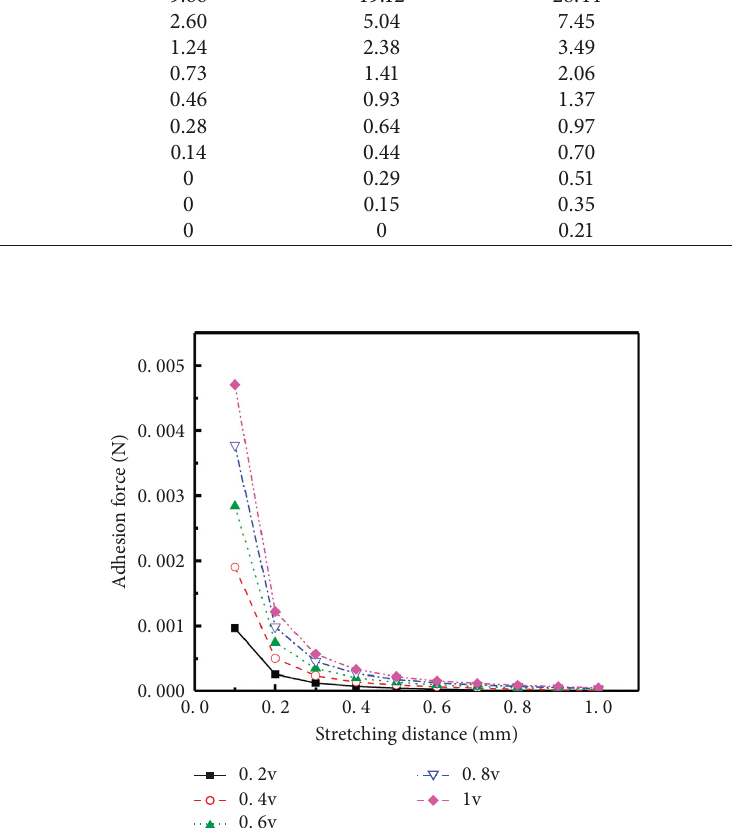
Figure 7: Variation curve of adhesion force of different liquid bridge volumes with stretching distance (40 °